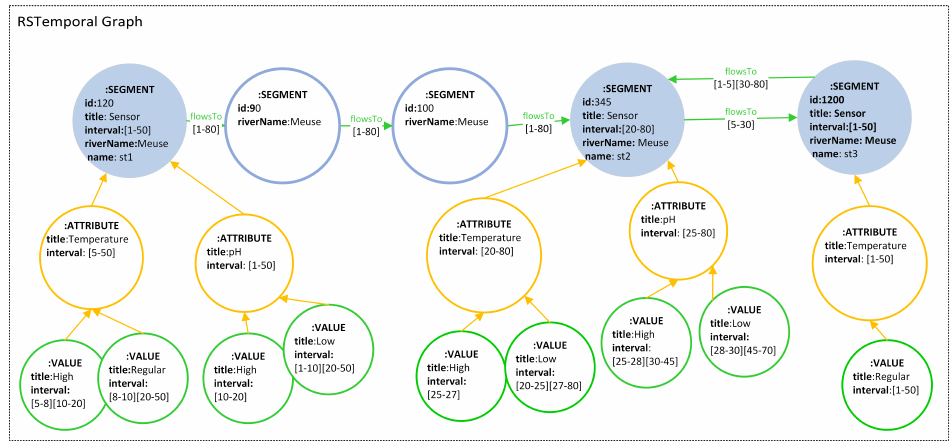
Figure 2. A temporal graph for a river network with sensors measuring Temperature and